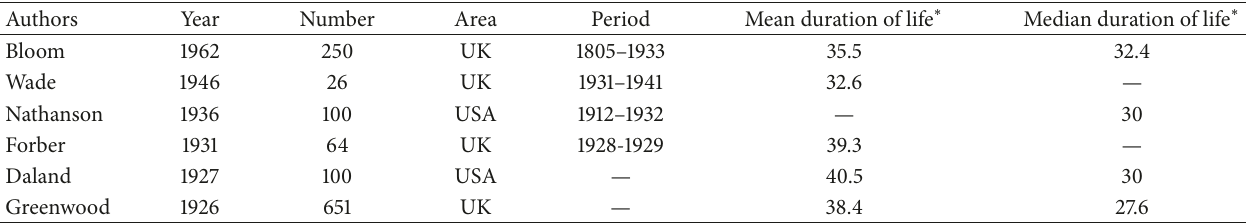
Table 1: Literature review on the natural history of untreated breast cancer. Adapted from H. J. Bloom, W. W. Richardson, and E. J. Harries, “Natural history of untreated breast cancer (1805–1933). Comparison of untreated and treated cases according to histological grade of malignancy.” Br Med J, vol. 2, no. 5299, p. 213, 1962